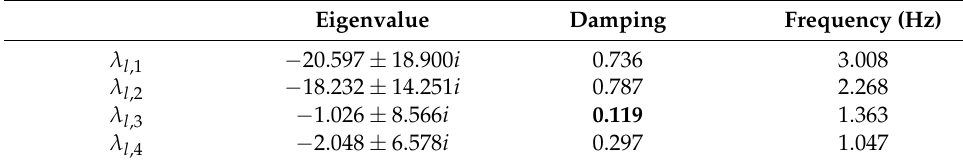
Table 1. Local modes (scenario A). Bold values highlight critical damping.